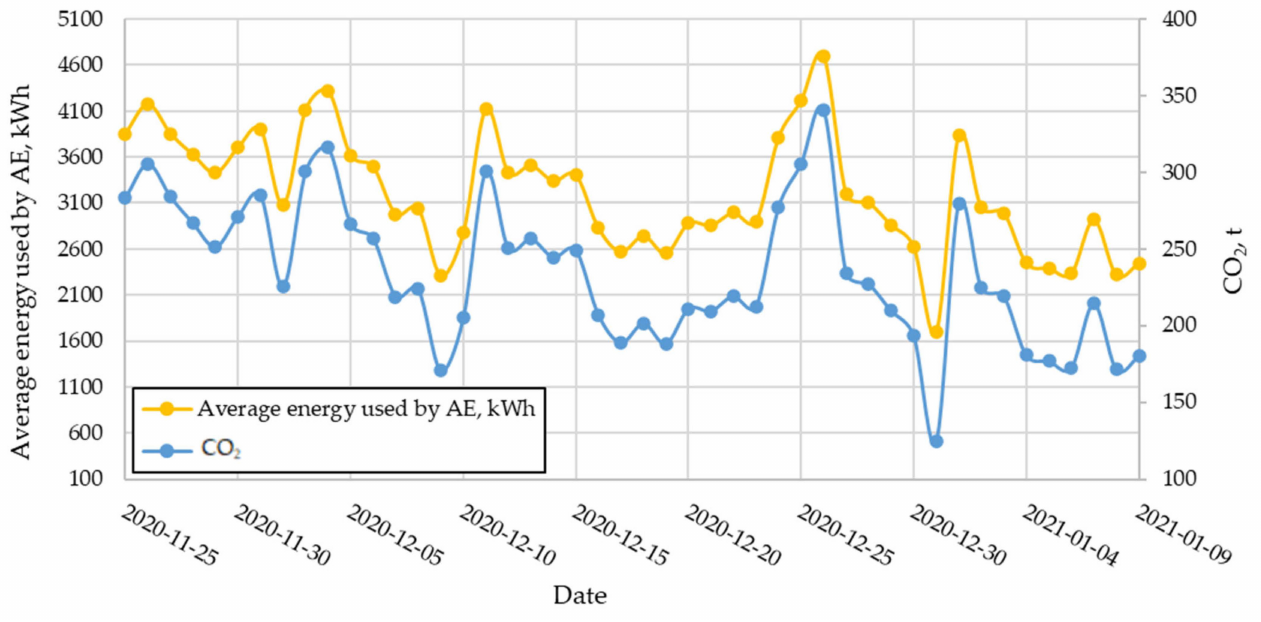
Figure 4. Ship generators produced energy and distribution in port and CO 2 emissions for each